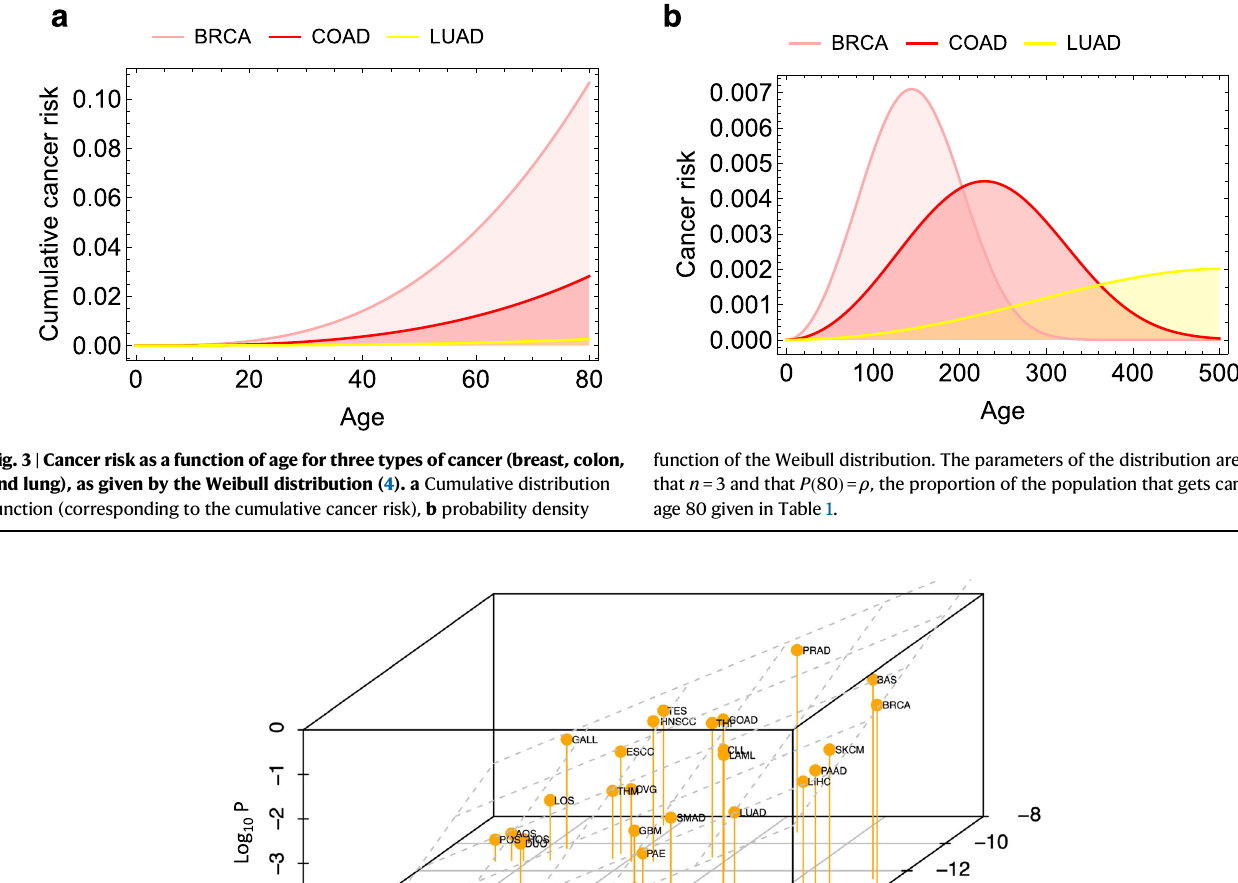
Fig.4 |Relationshipbetweenlifetimecancerrisk P ,numberofstemcells N ina giventissue,and uD ð Þ n for 26 cancertypes,where D is thenumberofdivisions in a stem cell lineage of that tissue, u the driver mutation rate, and n the